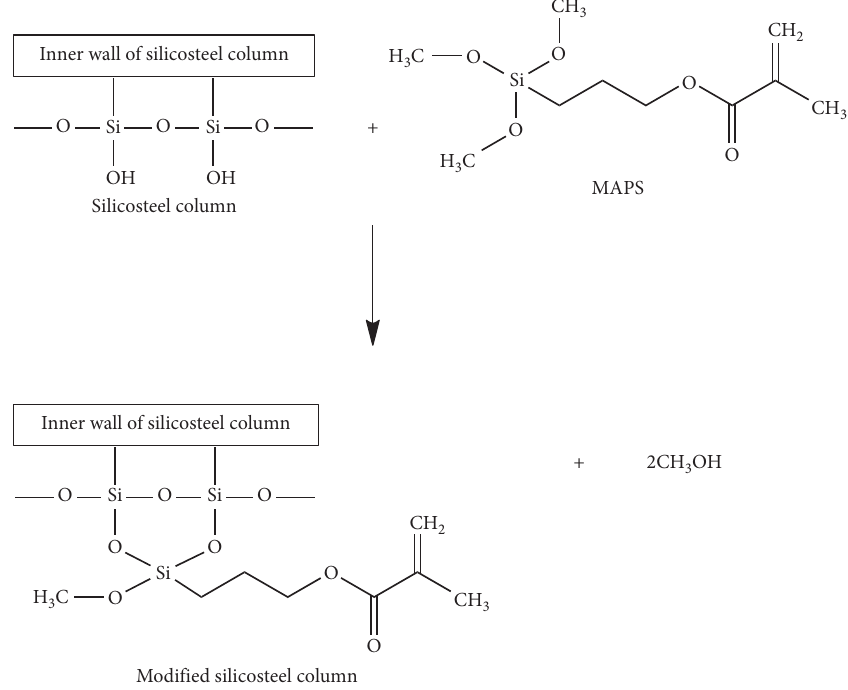
Figure 1: Silanisation reaction of the silicosteel column with MAPS [28].